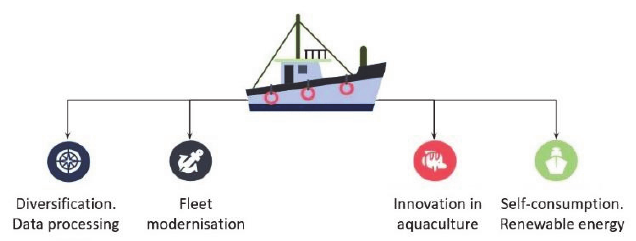
Figure 8. Key features for the Port of Vigo to address in order to become a green port. Source: own elaboration.